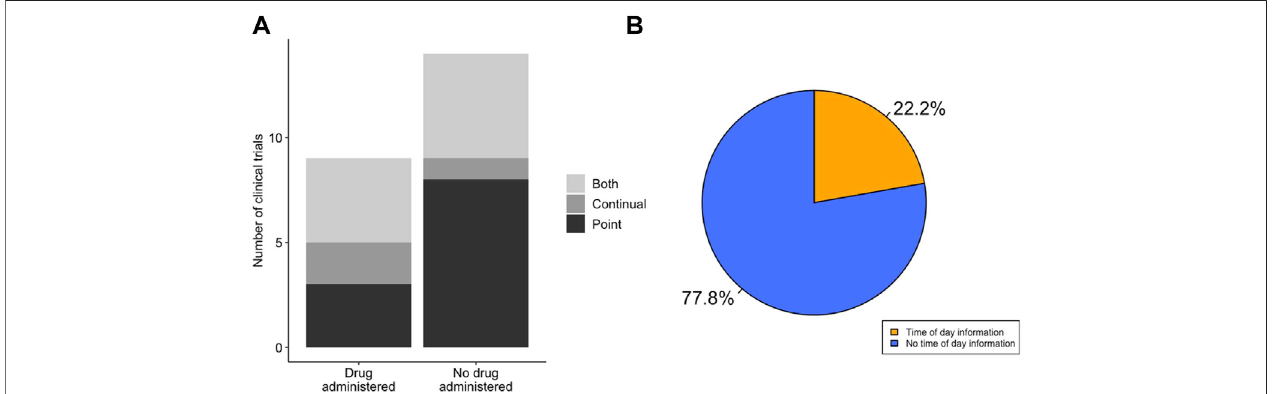
FIGURE 4 | LQTS drug studies do not show enhanced integration of diurnal information. (A) Method of ECG recording for LQTS clinical trials that did and not administeradrug.TrialswerescoredforwhetheroutcomesreportedECGmeasurementsdeterminedbypointECGmeasurement(black),continualusingHoltermonitor (darkgrey) or outcomes that used both point and continuous measurements (light grey). (B) Distribution ofLQTS trials that administered adrug that accounted (orange) or did not account (blue) for time of day information in drug delivery.